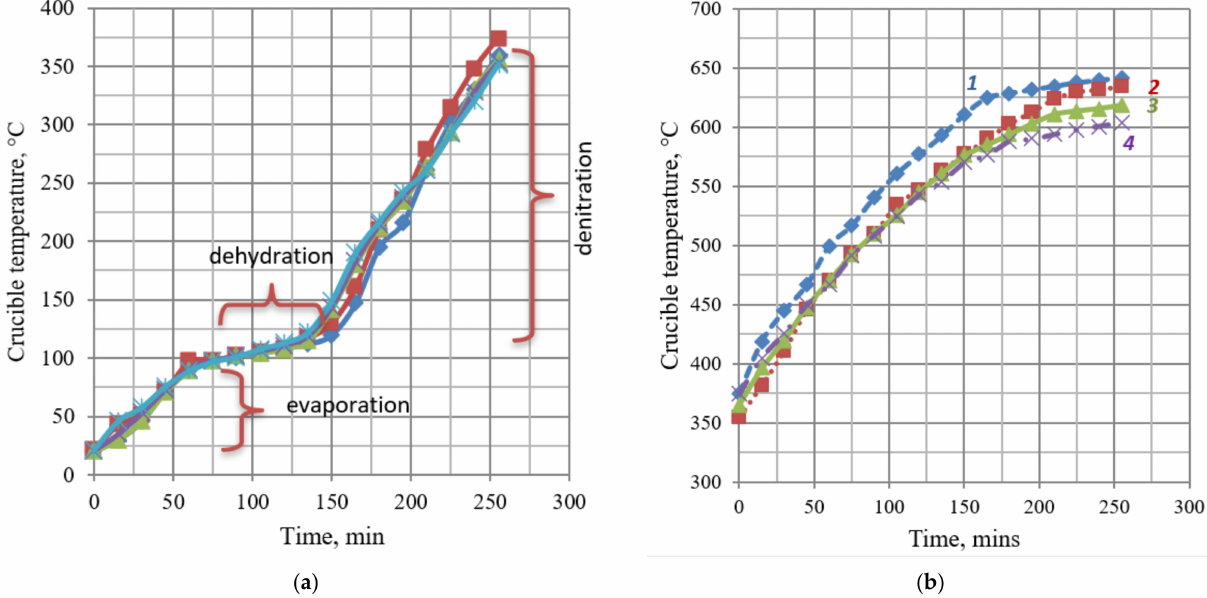
Figure 4. Time-varying crucible temperature graph during evaporation and denitration of cerium and uranyl nitrates by microwave heating ( a ) and a plot of crucible temperature versus time during microwave heating of uranyl and cerium nitrate denitration products in an argon–hydrogen medium ( b ): 1, crucible temperature with products of uranyl nitrate denitration; 2, temperature in the presence of 10% cerium; 3, temperature in the presence of 20% cerium; and 4, temperature in the presence of 30%